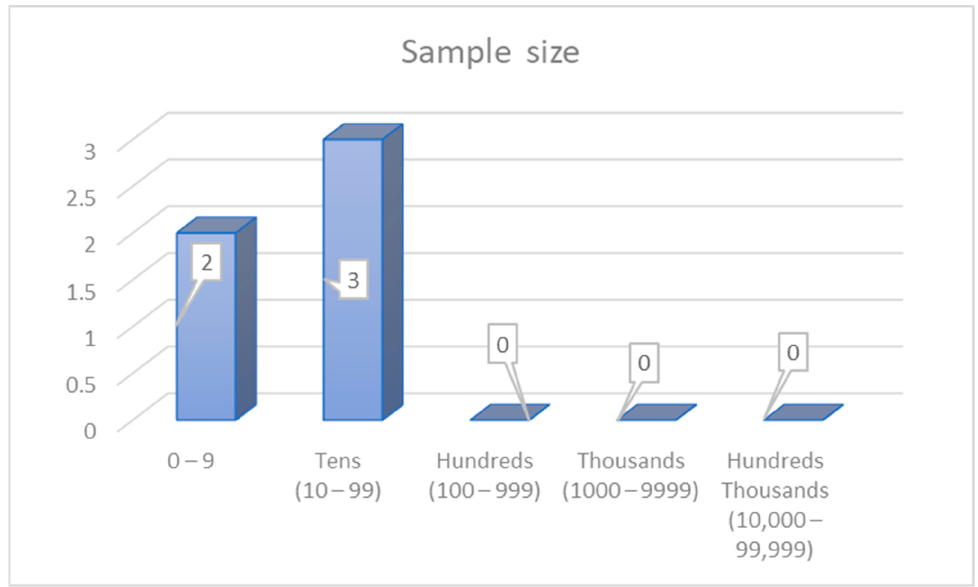
Figure 11. Sample sizes used in studies using real-time field tests.